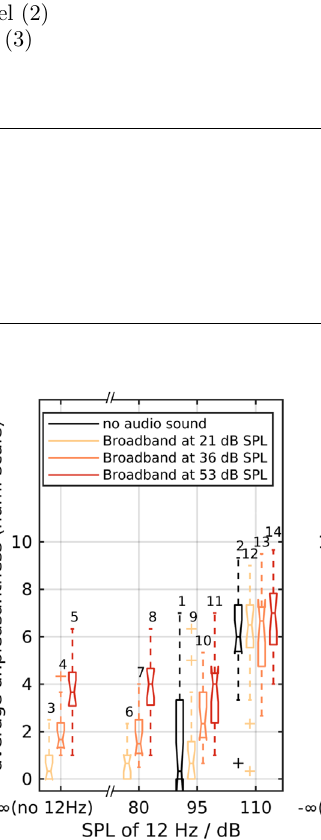
Figure 2. Boxplots of average unpleasantness ratings of 19 participants using an 11-point numerical scale for different stimulus combinations of infrasound and audio sound. The number above each boxplot refers to the stimulus number